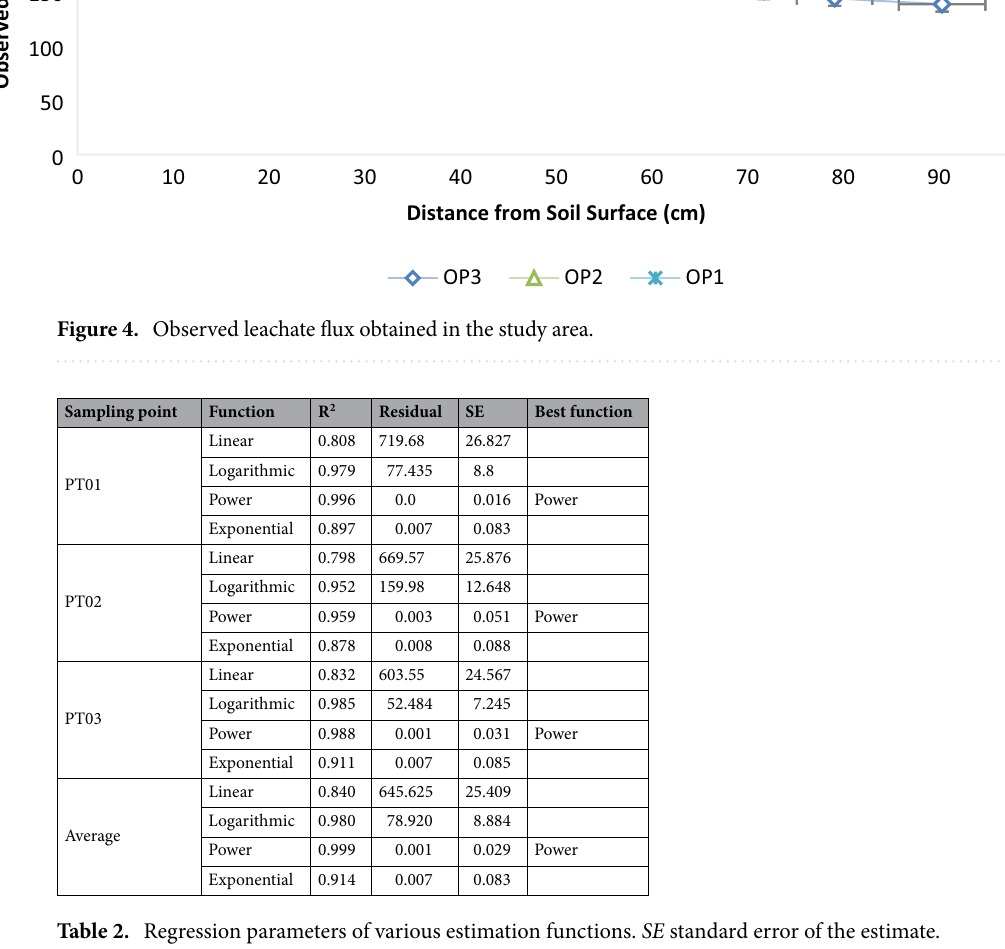
Table 2. Regression parameters of various estimation functions. SE standard error of the